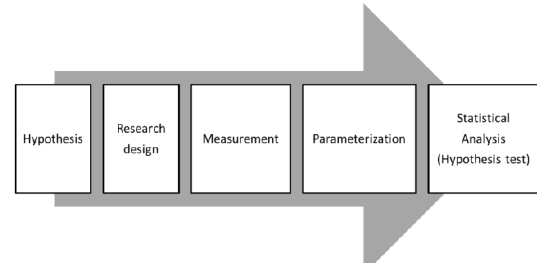
Fig.1: The steps from the formulation of a hypothesis to the testing of the hypothesis by statistical